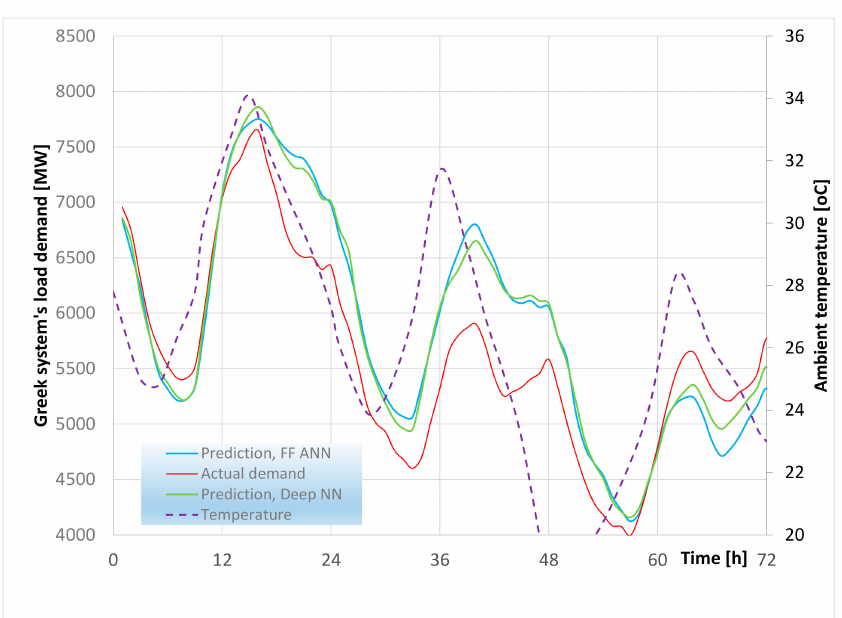
Figure 20. Incident of Thursday 7–Saturday 9 July: load prediction failure of both models during a sudden change to drier weather conditions and ambient temperature